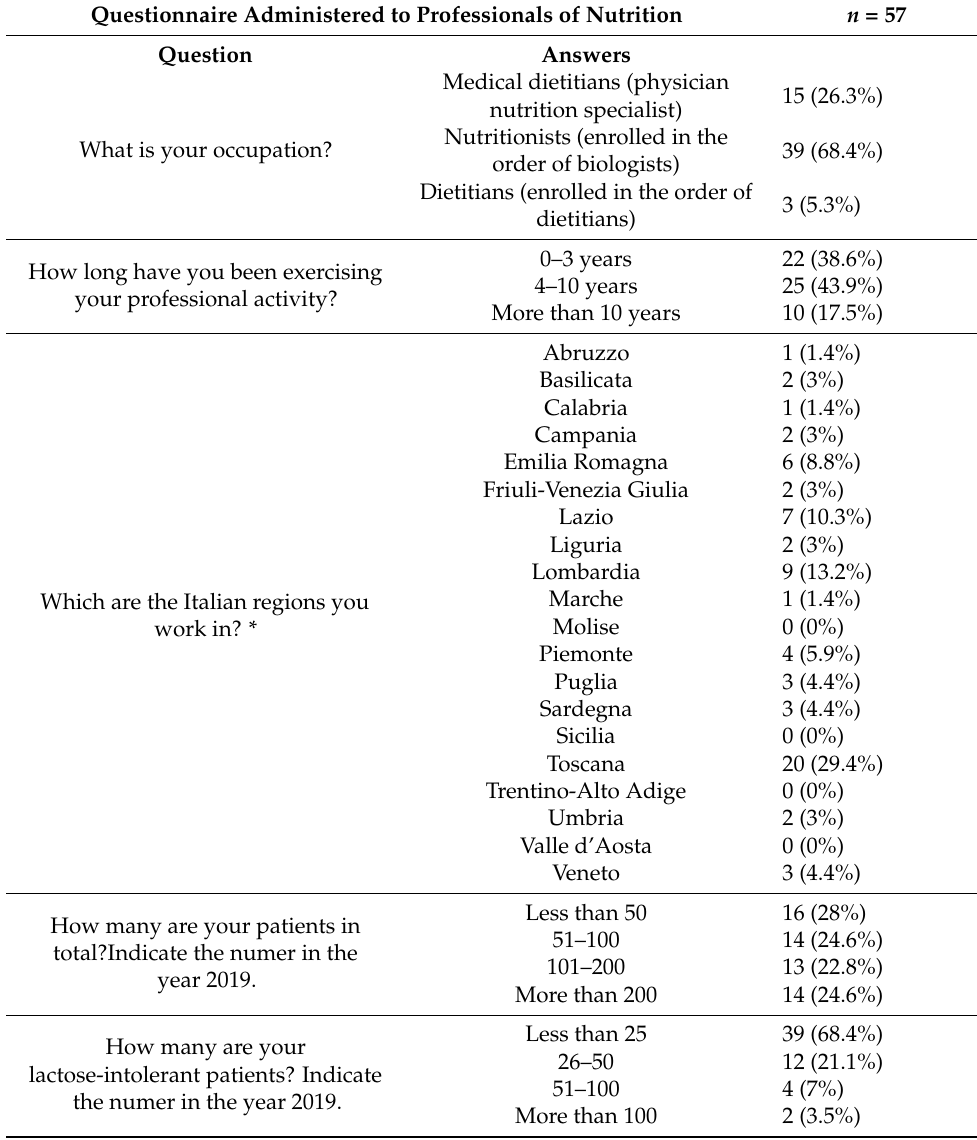
Table 3. Sociodemographic characteristics of the professionals of nutrition